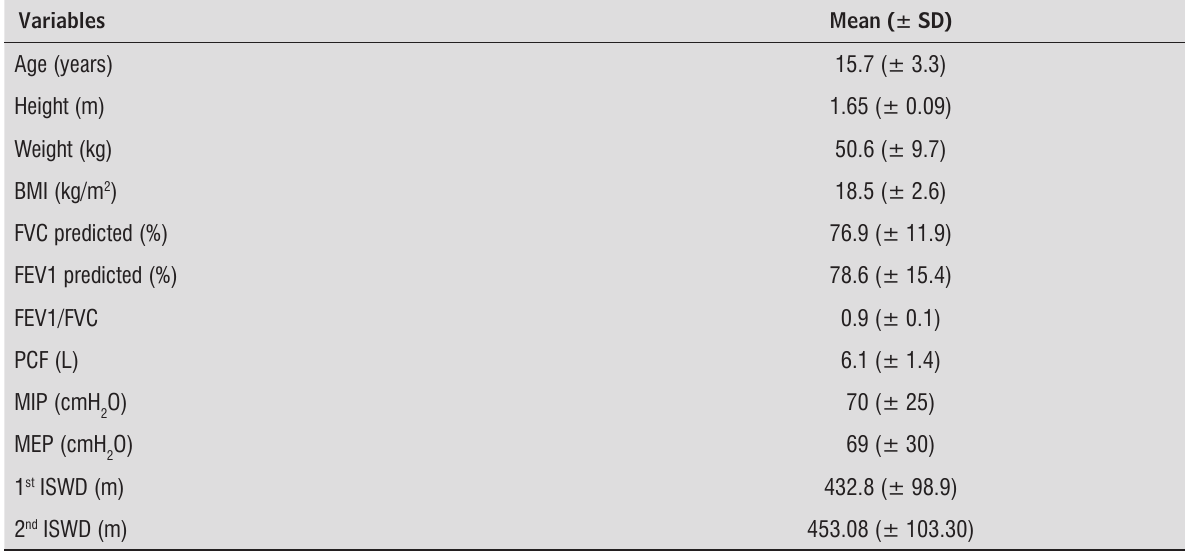
Table 1 - Demographic, anthropometric, lung function and respiratory muscle strength of the 27 patients